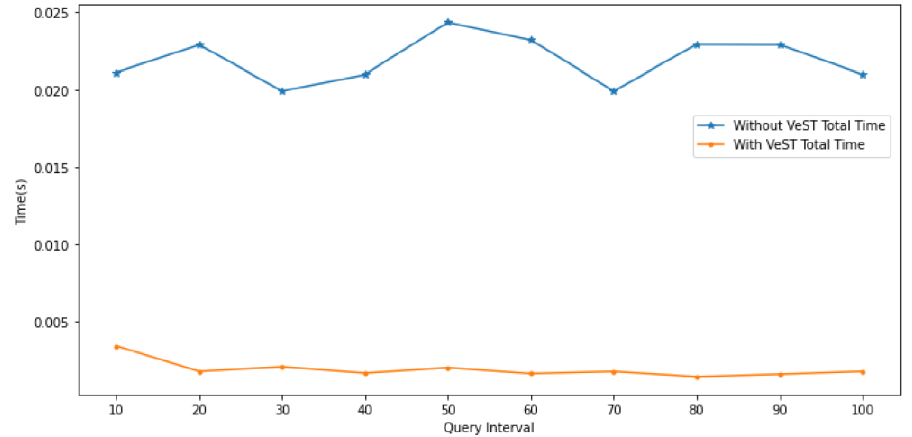
Figure 8. Effect of query interval length over query processing